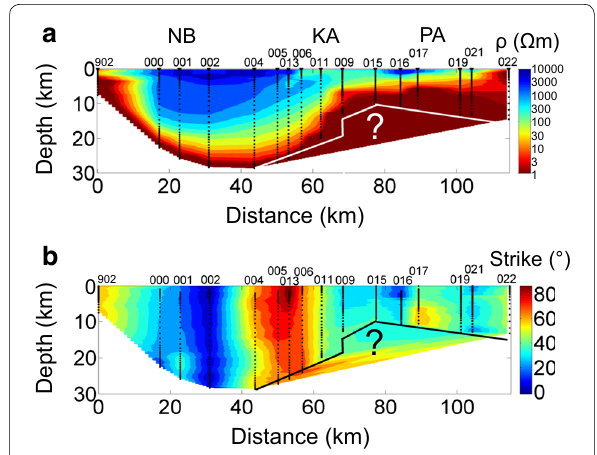
Fig. 15 a Resistivity image obtained using invariant data. b Corresponding strike directions plotted at the same depths as the resistivity values (modified from Muñíz et al. (2017). NB stands for Nelson Batholith, KA for Kootenay Arc and PA for Purcell